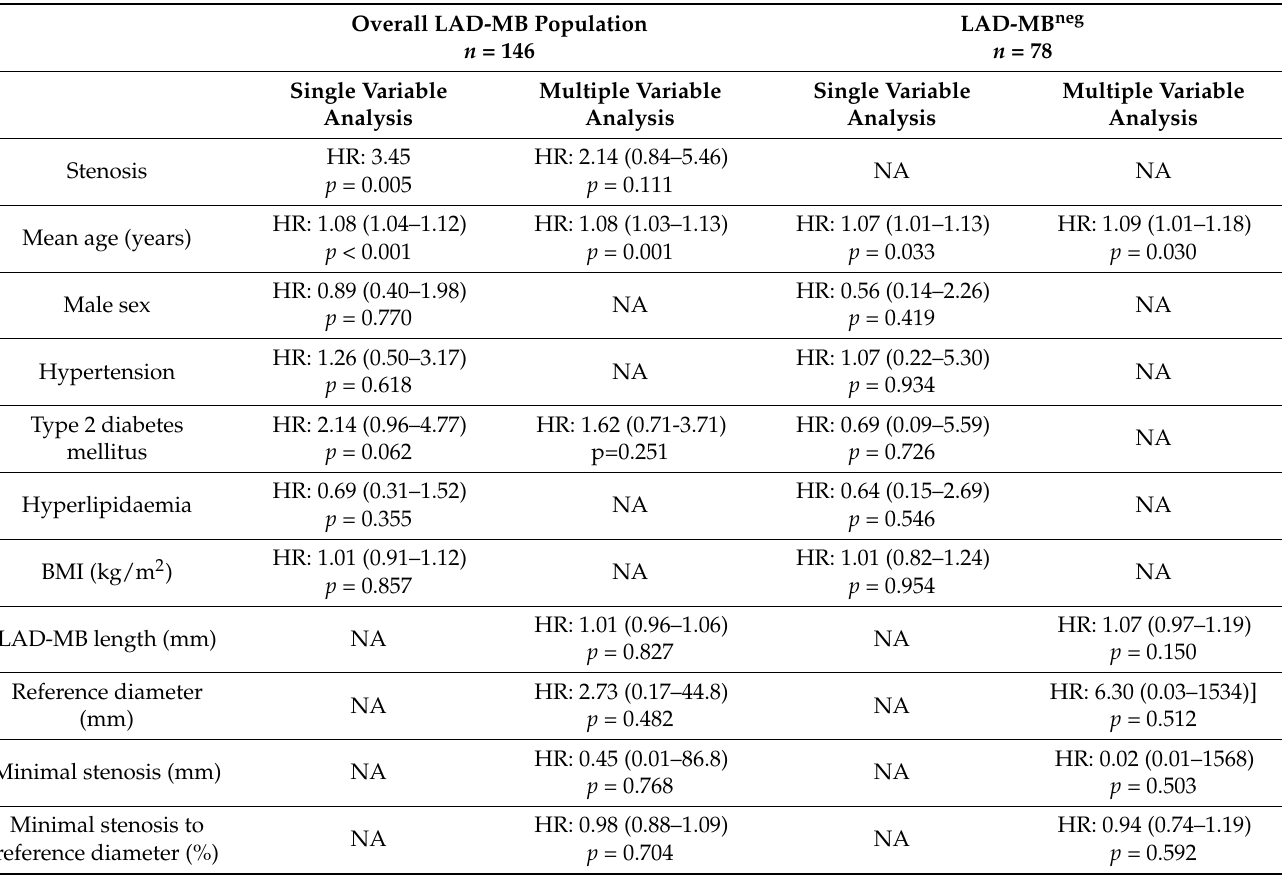
Table 2. Summary of univariate and multivariate Cox regression analysis of overall survival in overall population and LAD-MB neg group. Overall LAD-MB Population n = 146 Single Variable Multiple Variable Analysis Analysis